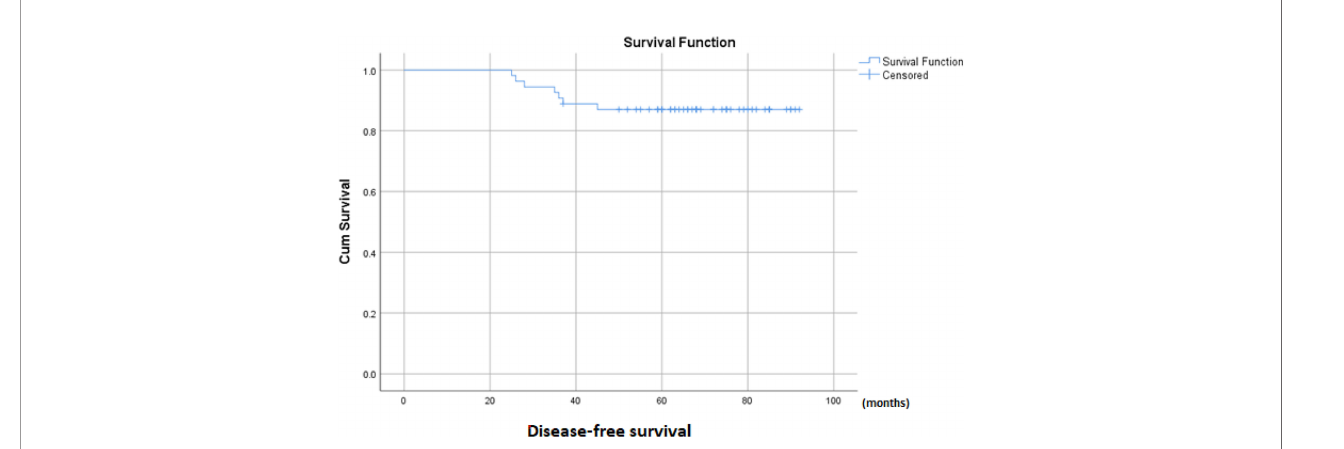
FIGURE 1 | Kaplan – Meier curves estimating disease-free survival of pediatric cN0 papillary thyroid